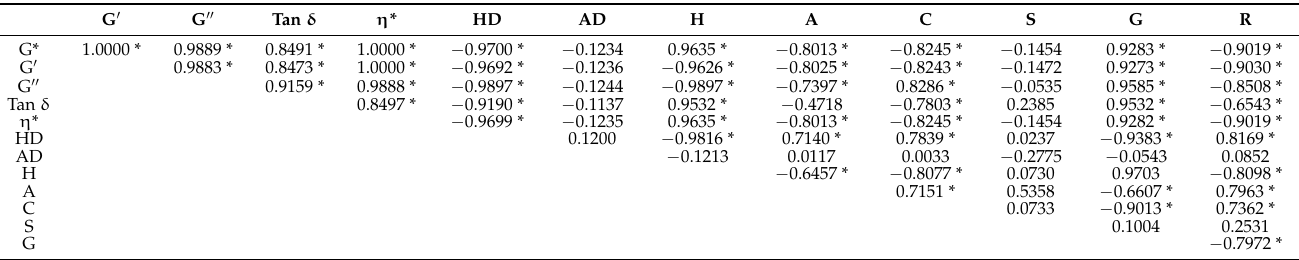
Table 7. Pearson correlation coefficients among rheological parameters (G*, G (cid:48) , G (cid:48)(cid:48) , Tan δ , and η *), height deviation (HD), area deviation (AD), and TPA parameters (hardness, adhesiveness, cohesiveness, springiness, gumminess, and resilience) of